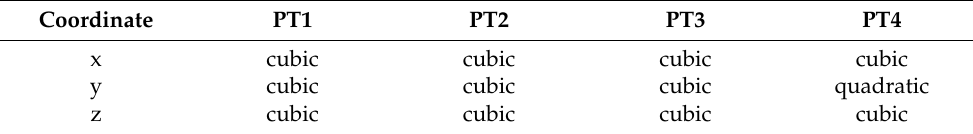
Table 1. Degree of the polynomial trends used to reduce the observed displacements. Coordinate PT1 PT2 PT3 PT4 x cubic cubic cubic cubic y cubic cubic cubic quadratic z cubic cubic cubic